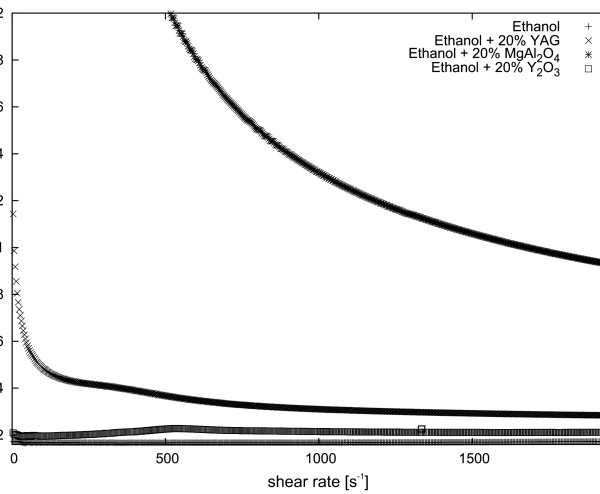
Dynamic viscosity dependence of 20 wt. % Y2O3, Y3Al5O12, MgAl2O4suspensions in ethyl alcohol at 10°C.